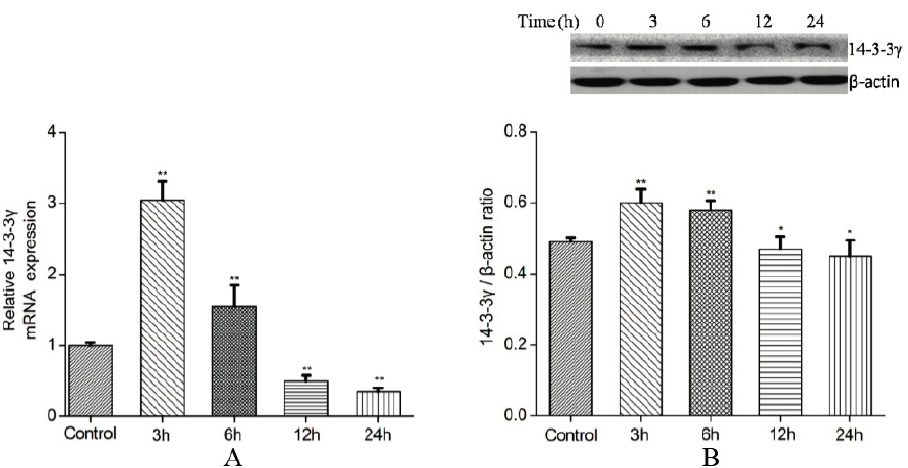
Figure 2. Effect of lipopolysaccharide (LPS) on the expression of 14-3-3 γ in DCMECs. DCMECs were treated with 1 μ g/mL LPS for 0, 3, 6, 12 and 24 h, relative expression levels of 14-3-3 γ were determined by qRT-PCR and western blot ( A ) The relative expression of 14-3-3 γ mRNA; ( B ) The relative expression of 14-3-3 γ protein. All of these expressions were normalized to a housekeeping gene ( β -actin ). Bars indicate the mean ± SD ( n = 3). * p < 0.05 and ** p < 0.01 vs. control group.